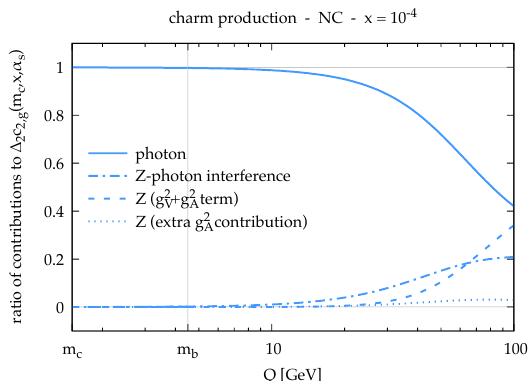
Figure 6 . Ratio of the photon, Z and photon- Z interference contributions to the resummed massive coe(cid:14)cient function (cid:1) 2 c 2 ;g ( m c ), shown for (cid:12)xed x = 10 (cid:0) 4 as a function of Q from m c to 100 GeV. NC and (cid:1) c CC ( m ), (cid:1) c CC ( m ) and (cid:1) c CC ( m ) in CC 15 as a function of Q for two 2 c 2 c 2 c 2 ;g 3 ;g L;g